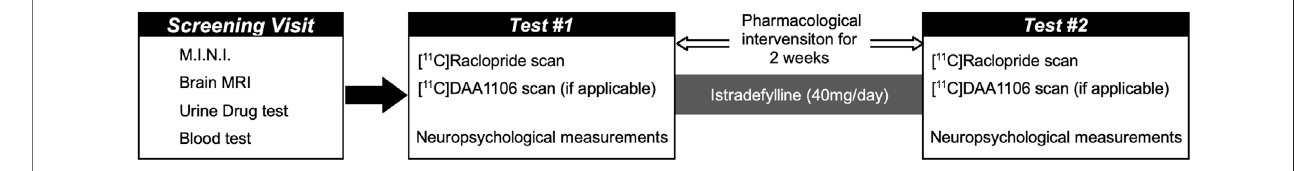
FIGURE 1 | Schematic diagram of the